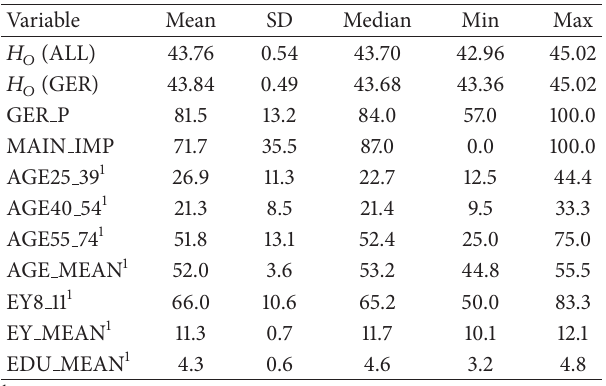
Table 2: Descriptive statistics of genetic diversity and socio- demographic measures per LU (mean, standard deviation, median, minimum value, and maximum